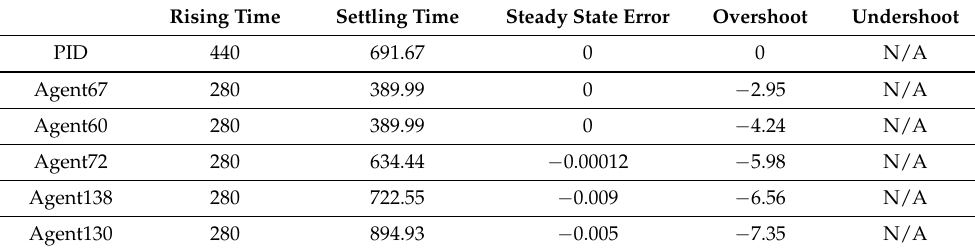
Figure 6. Plot of control deviation for: ( a ) the best 15 neural network agents ( b ) PID controller. Table 2. The improved performances of PID and different neural agents